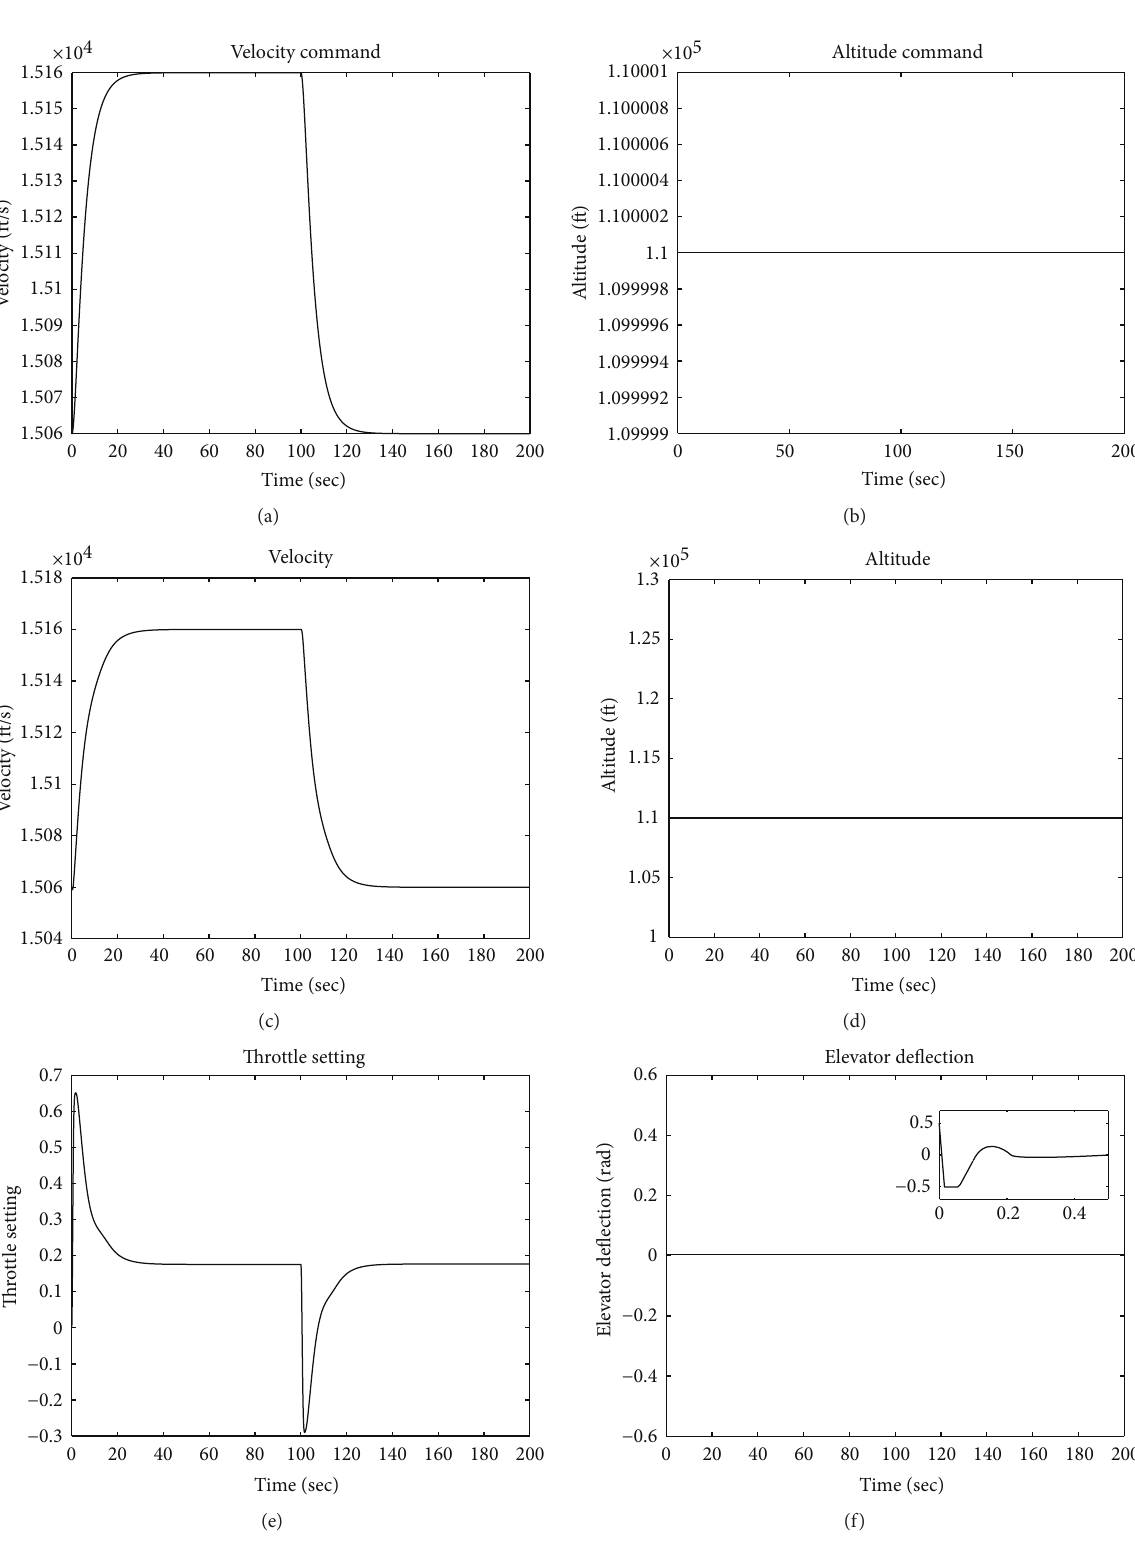
Figure 1: Velocity command, response, and controller. The uncertainty terms are added into the